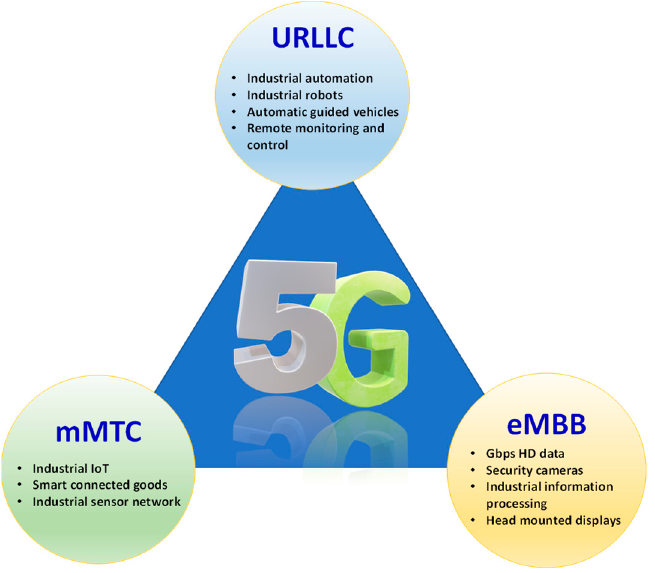
Figure 1. Avenues of 5G services in the viewpoint of Industry 4.0 and beyond.